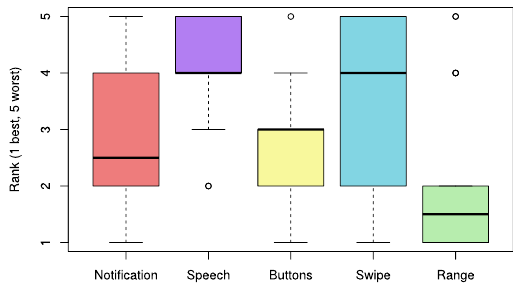
Fig. 3. Ranking of the input methods (1 best, 5